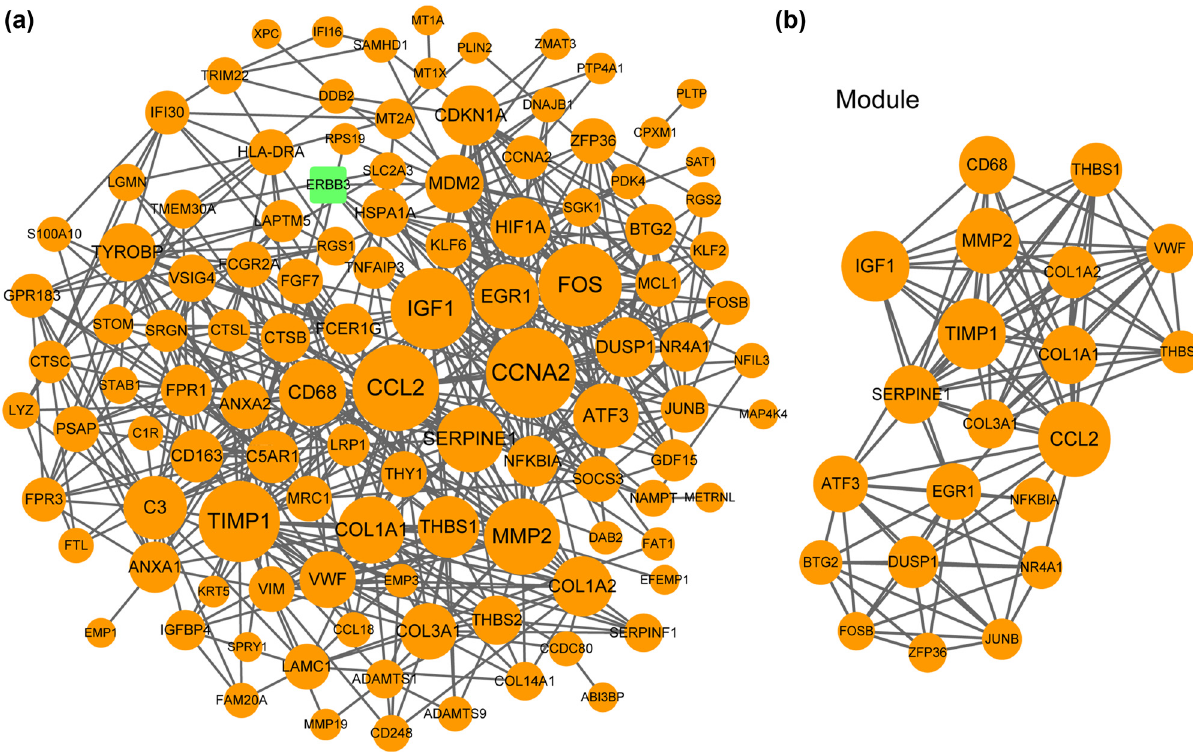
Figure 2: The PPI network and the important module of the radiation - associated genes in BCa: ( a ) the PPI network consisted of 111 upregulated and 1 downregulated radiation - associated genes in BCa and ( b ) the important module ( score = 9.9, 21 nodes ) identi fi ed using MCODE. Node size indicates the interaction degree. The higher the degree, the larger the node size is. The one downregulated radiation - associated gene is presented by blue